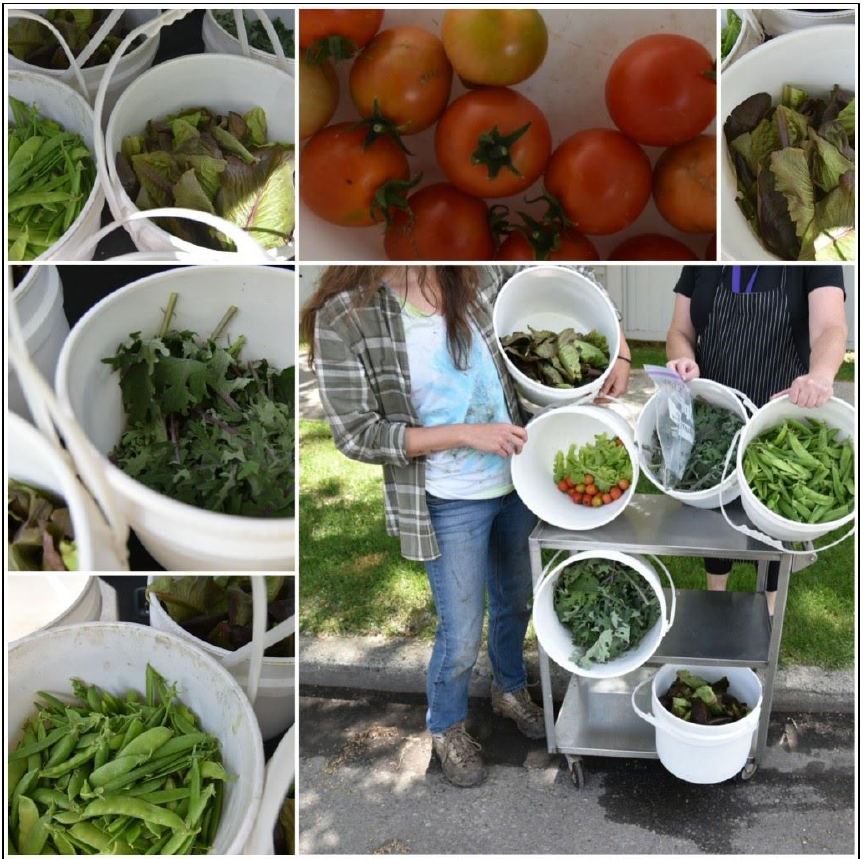
Figure 1. Delivering Fresh Produce to a Calgary-based Social Agency